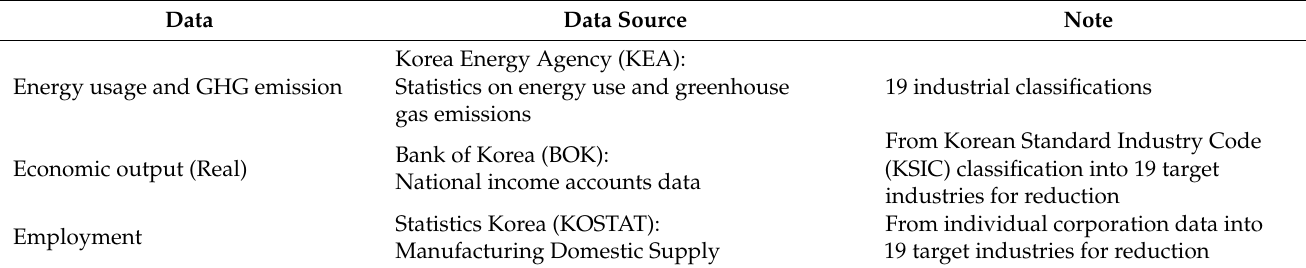
Table 1. Data Sources (Year: 2016, 2019).